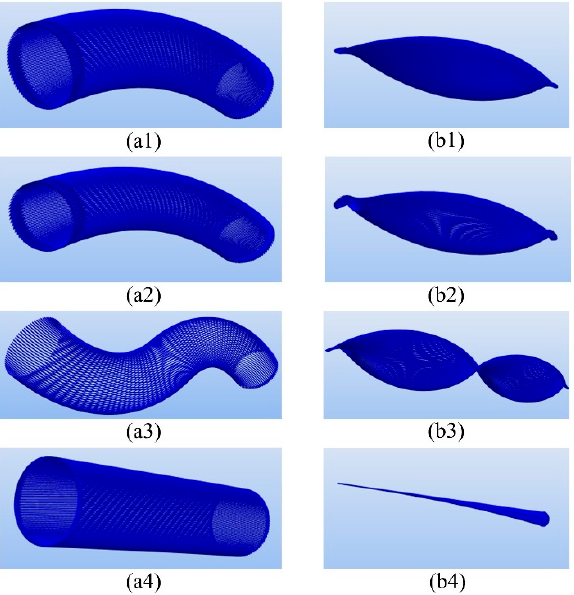
Figure 14. Print path simulation results: ( a1 ) Before rotation, circular section and plane single segment curve, ( a2 ) Before rotation, elliptic section and plane single segment curve, ( a3 ) Before rotation, circular section and plane multi-segment curve, ( a4 ) Before rotation, circular section and space curve, ( b1 ) After rotation, circular section and plane single segment curve, ( b2 ) After rotation, elliptic section and plane single segment curve, ( b3 ) After rotation, circular section and plane multi-segment curve, ( b4 ) After rotation, circular section and space curve.